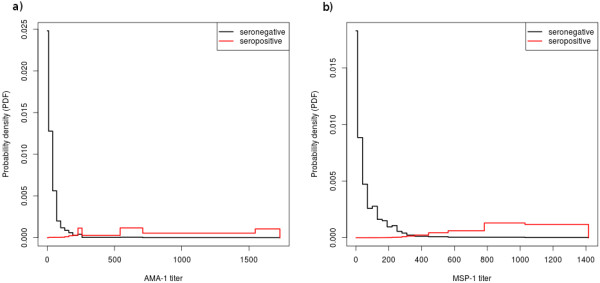
Results of the mixture decomposition. Graphical representation of the estimated probability densities of the titre distributions in seronegative and -positive individuals, respectively, for both AMA-1 (a) and MSP-1 antibodies (b). An average of the PDFs, weighted by relative abundance of positive and negative individuals, approximately yields the PDF of the titre data.